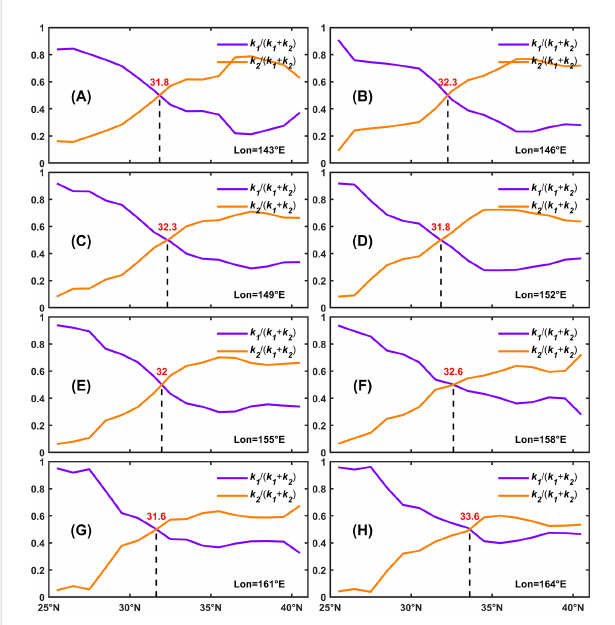
FIGURE 8 Relative values of coef fi cients as a function of latitudes at (A) 143°E, (B) 146°E, (C) 149°E, (D) 152°E, (E) 155°E, (F) 158°E, (G) 161°E and (H) 164°E. The bold lines indicate the relative values of coef fi cients derived from multi-year averaged seasonal cycles at different latitudes. The shading areas denote the standard deviations of coef fi cients calculated from the seasonal cycle of each year at different